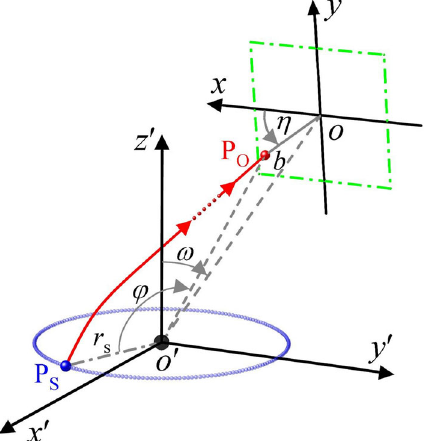
Fig. 2 The coordinate system for the description of photon trajectory (red line) that emits from the disk element P S and vertically intersects the observational plane (The area enclosed by the green dashed line) at pointP O .Here,thediskelementismovingaroundSchwarzschild-MOG BHinastablecircularorbit(blueline)ofradius r s ,pointP O ismarkedby polar coordinates ( b ,η) . The photon deflection angle and viewing angle arerepresentedby ϕ and ω ,where ω satisfiedthecondition0 ≤ ω < 90